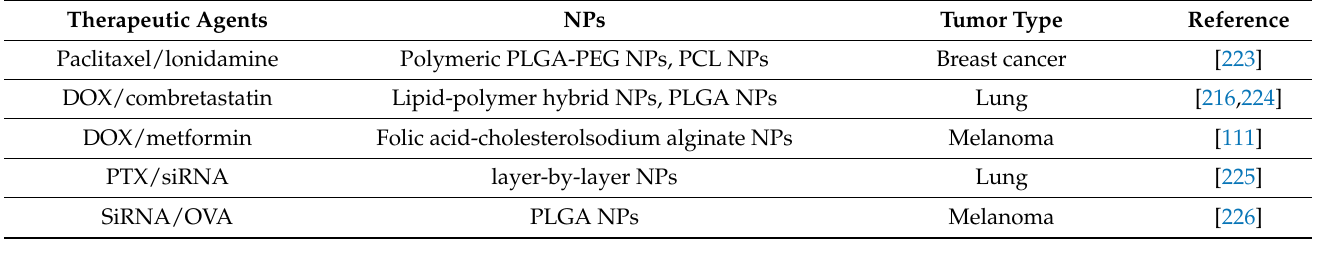
Table 4. List of polymer NPs for combination therapy.